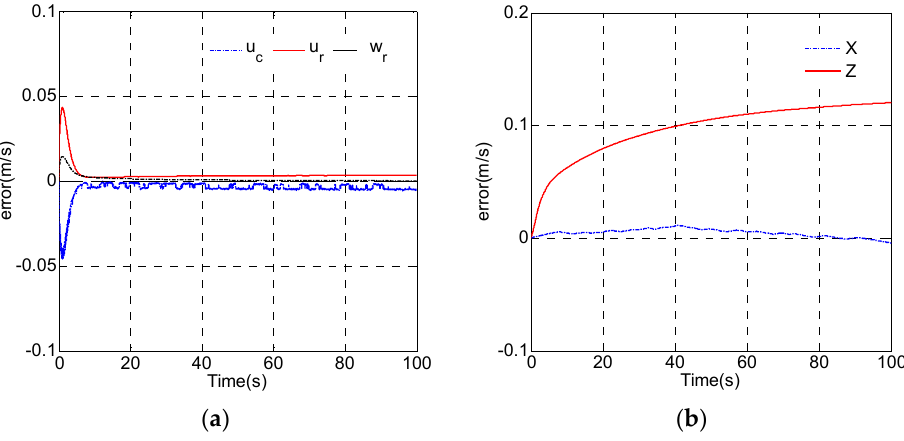
Figure 20. Observed error of velocity and position: ( a ) velocity error; ( b ) position error.